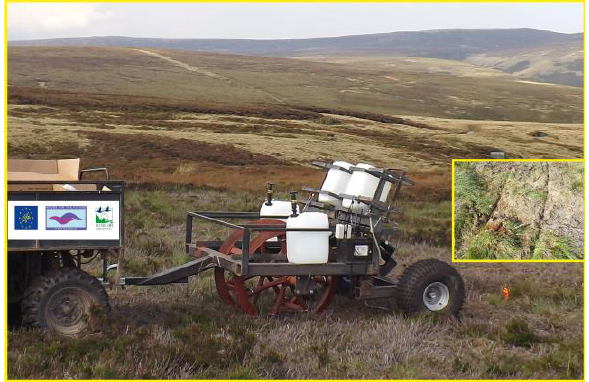
Figure 12. Prototype planting machine